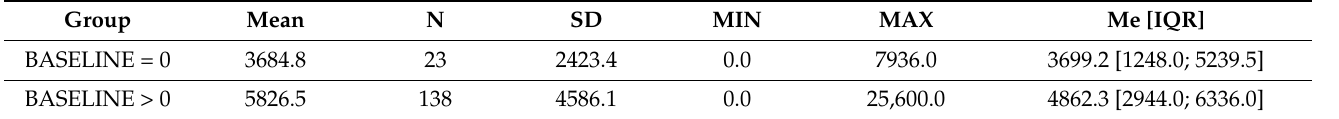
Table 2. Antibody levels after the first dose of anti-SARS-CoV-2 vaccine in convalescents [IU/mL].